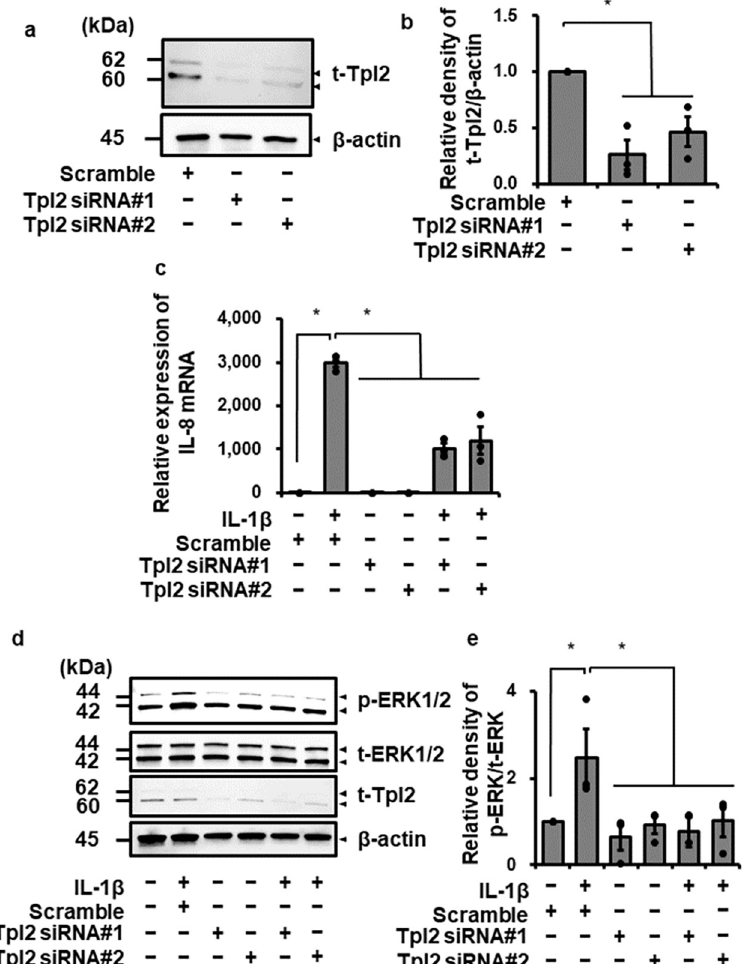
Fig 6. Attenuation of IL-1 β -induced IL-8 mRNA expression in canine dermal fibroblasts transfected with Tpl2 siRNAs. (a, b) In canine dermal fibroblasts transfected with two kinds of Tpl2 siRNA or scrambled siRNA, expression of total Tpl2 (t-Tpl2) and β -actin was detected by western blotting. The expression of t-Tpl2 was reduced in cells transfected with both Tpl2 siRNAs, but not in cells transfected with scrambled siRNA. β -actin was used as an internal standard. Representative results (a) and relative density of t-Tpl2 expression, shown as [t-Tpl2// β -actin], in siRNA- transfected cells compared with those in scrambled siRNA-transfected cells (b) are depicted. (c) Canine dermal fibroblasts transfected with Tpl2 and scrambled siRNAs were incubated with or without IL-1 β (100 pM) for 6 h. After the incubation, IL-8 mRNA expression was determined. TBP was used as an internal standard. Transfection with Tpl2 siRNAs resulted in attenuation of IL-1 β -induced IL-8 mRNA expression, while scrambled siRNA-transfection did not. (d, e) Fibroblasts transfected with Tpl2 and scrambled siRNAs were stimulated with or without IL-1 β for 15 min. After the stimulation, phosphorylated ERK1/2 (p-ERK1/2), total ERK1/2 (t-ERK1/2), t-Tpl2 and the internal standard β - actin were detected by western blotting. The expression of p-ERK1/2 was reduced in Tpl2-knockdown cells, but not in scrambled siRNA-transfected cells. No change of t-ERK1/2 expression was observed in all cells. Representative results (d) and relative density of [p-ERK1/2/t-ERK1/2] in Tpl2 siRNA-transfected cells compared with those in scrambled siRNA-transfected cells (e) are depicted. Results have been represented as mean ± SE from biological triplicates. � P < 0.05.